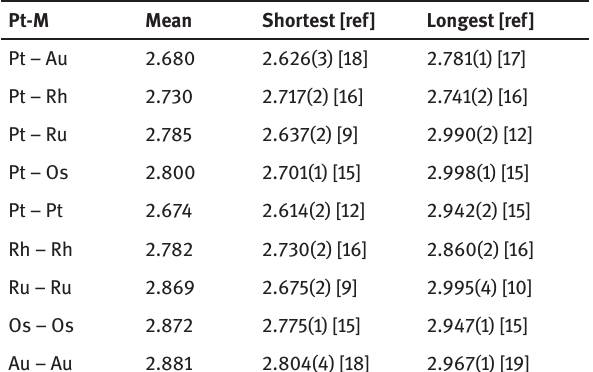
Table 2: Summary of the Pt-Pt, Pt-M and M-M bond distances [Å] (<3.0 Å) in heterononanuclear platinum clusters.